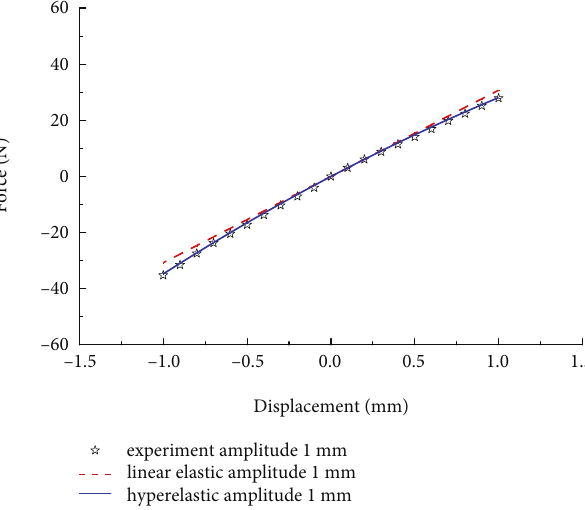
Figure 11: RIP force – displacement